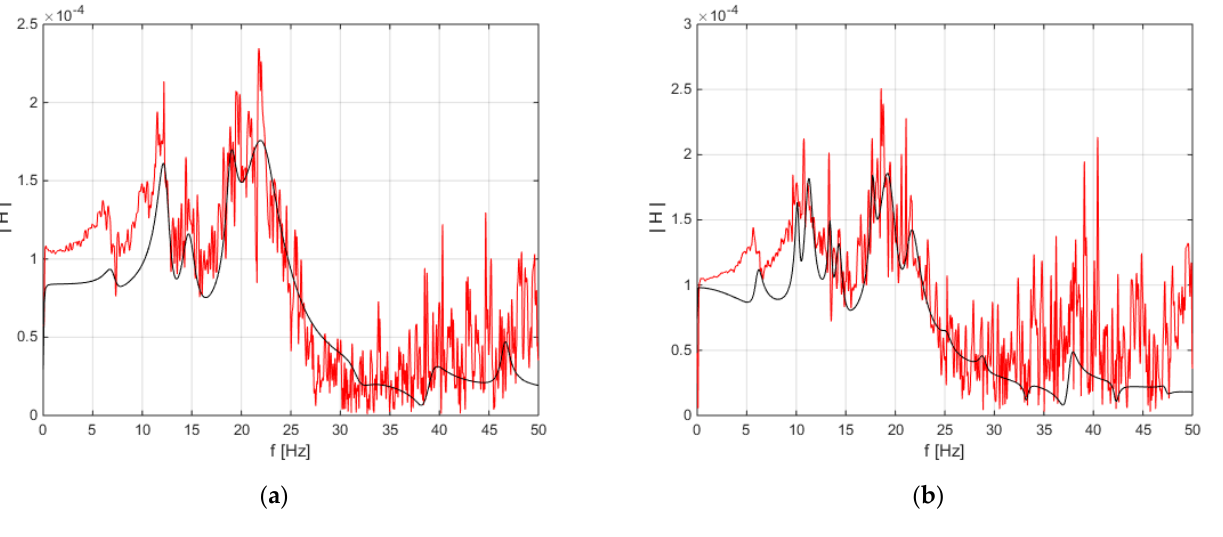
( d ) Figure 7. Frequency response functions of the calibrated FE models vs. the experimental data for test phases 1 to 4 from ( a – d ) respectively.